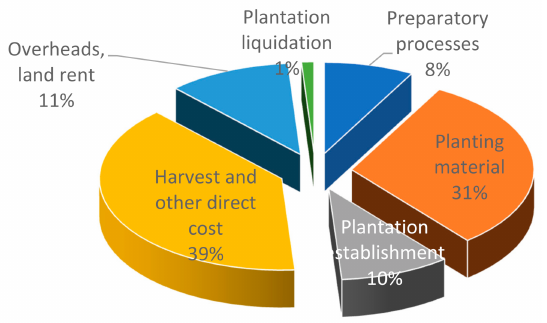
Figure 5. The cost structure of the Miscanthus biomass production divided into categories (in current values, with a nominal discount of 10%, Yc 5 = 10 t DM ha − 1 y − 1